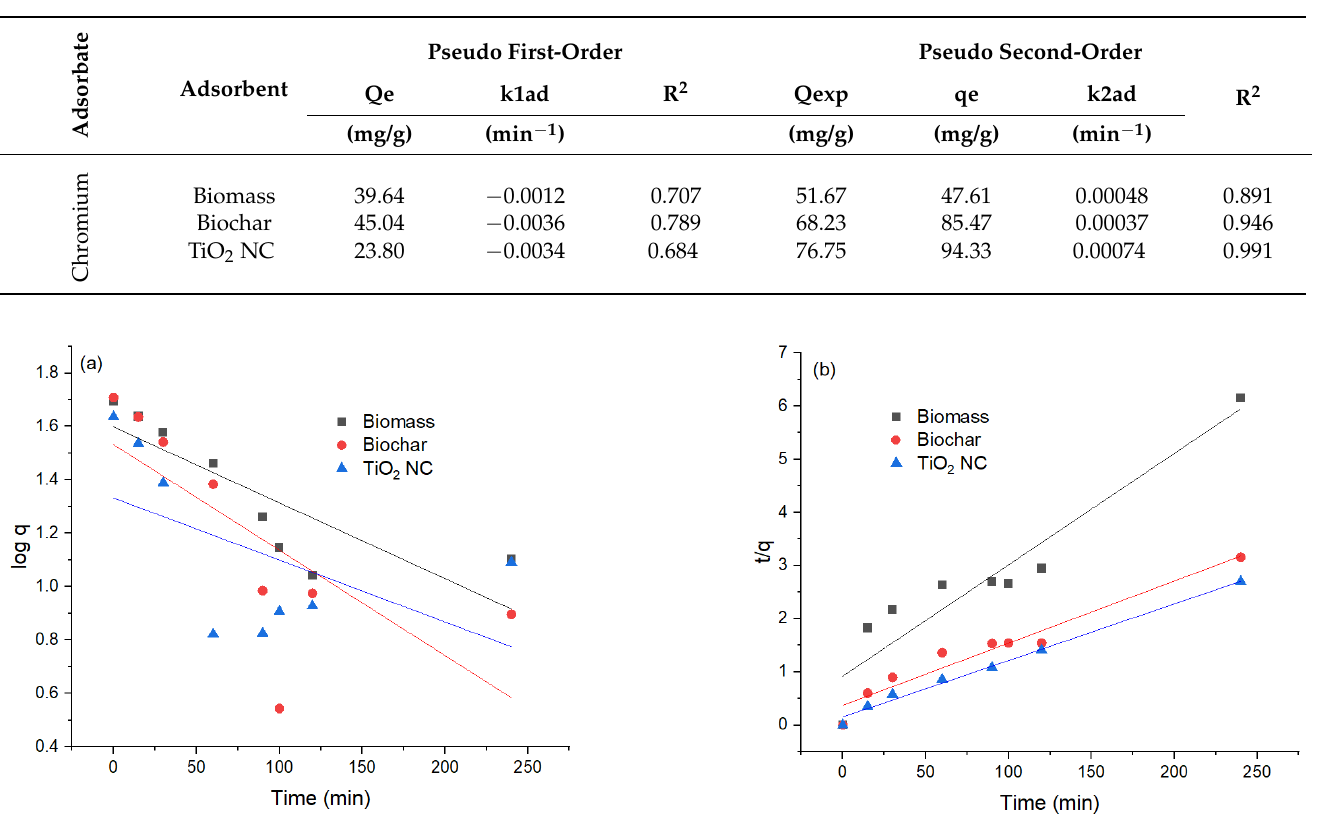
Figure 8. ( a ) Comparison of pseudo 1st-order graph; ( b ) pseudo 2nd-order graph.